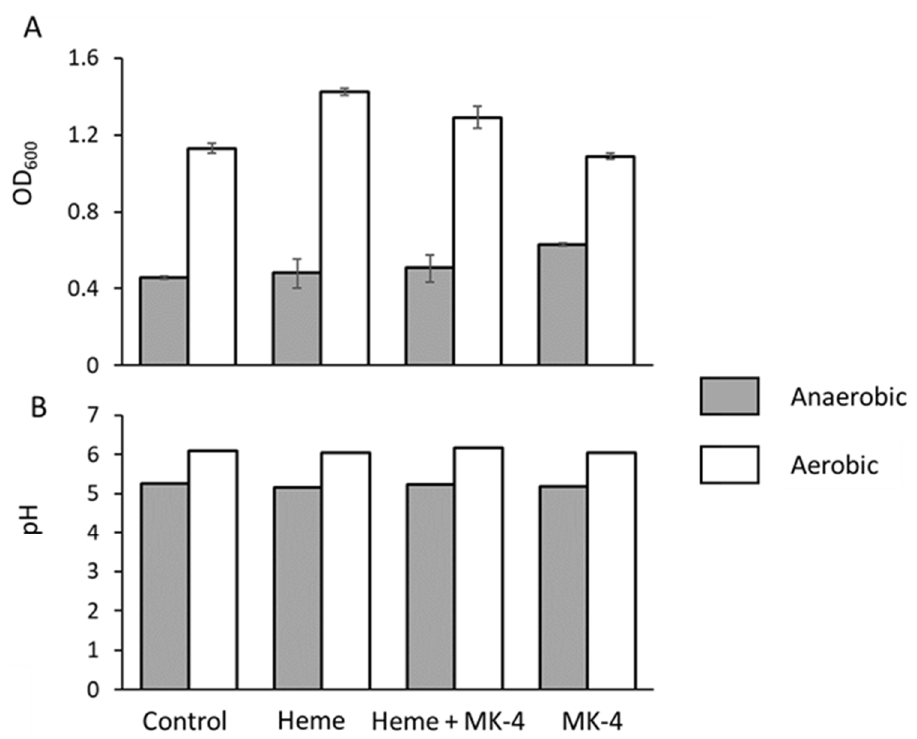
Figure 3. ( A ) Growth of E. faecalis as endpoint measurements of turbidity (OD 600 ) and ( B ) endpoint pH measurements after growth with different supplements to stimulate respiratory behavior.